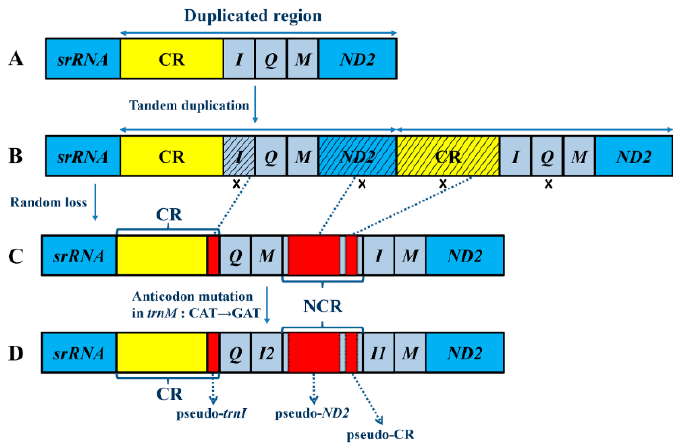
Figure 6. The hypothetical process of gene rearrangement in the model of tandem duplication/random loss and duplication/anticodon mutation: ( A ) the ancestral gene order in insects; ( B ) the tandem duplication of CR/ trnI / trnQ / trnM / ND2 ; ( C ) the random loss of the duplicated trnI , ND2 , CR and trnQ ; and ( D ) the anticodon mutation in trnM which changes trnM (CAT) to trnI2 (GAT). “x” indicates the random loss of the duplicated genes. Shaded areas indicate the genes or regions that are partially lost. Dotted arrows connect the original genes to the rearranged products. Random lost genes and their corresponding pseudo genes are indicated by blue dotted lines. CR is the abbreviation for control region and NCR is the abbreviation for non-coding region.